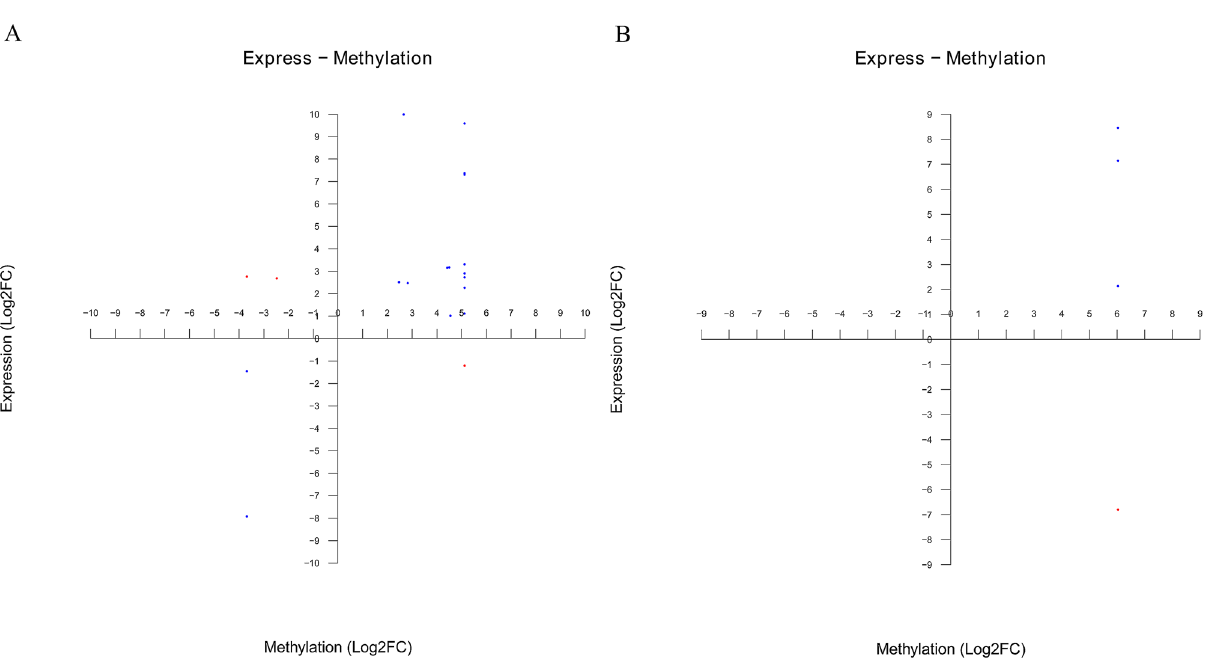
Figure 8. Differentially expressed genes and differential methylation quadrants ( A : CCGG site; B : CCWGG site). Red indicates the locus of negatively correlated differentially expressed genes, and blue indicates the locus of positively correlated differentially expressed